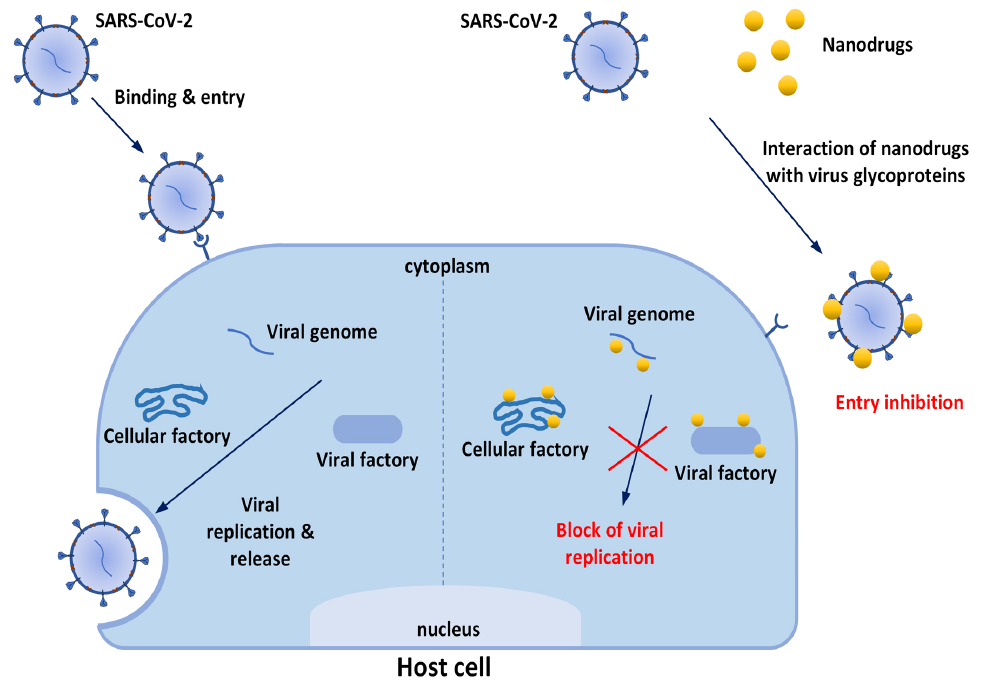
Figure 2. Possible mechanisms involved in the effectiveness of nanodrugs for prevention and treatment of